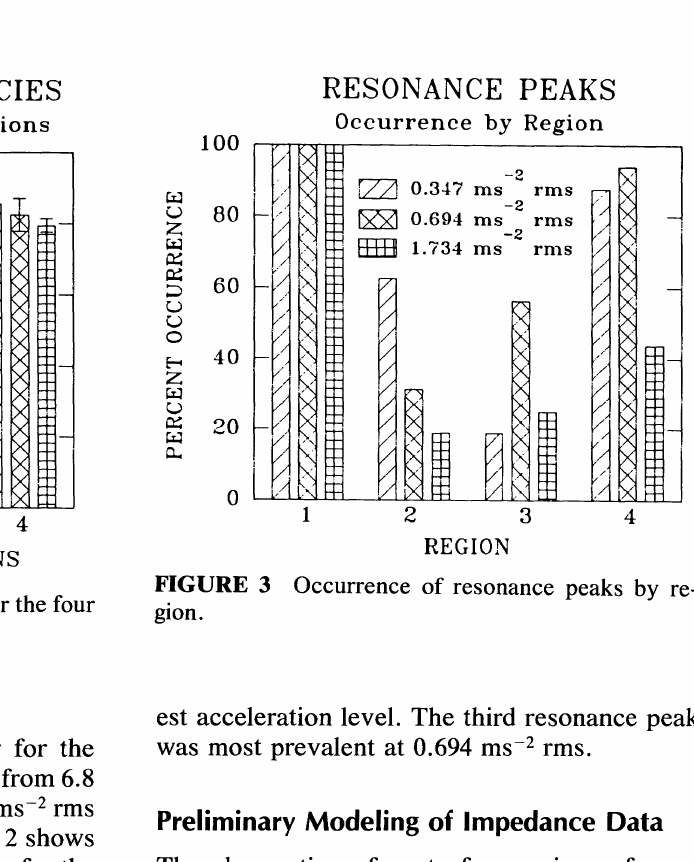
figure. The mean resonance frequency for the first resonance region shifted downward from 6.8